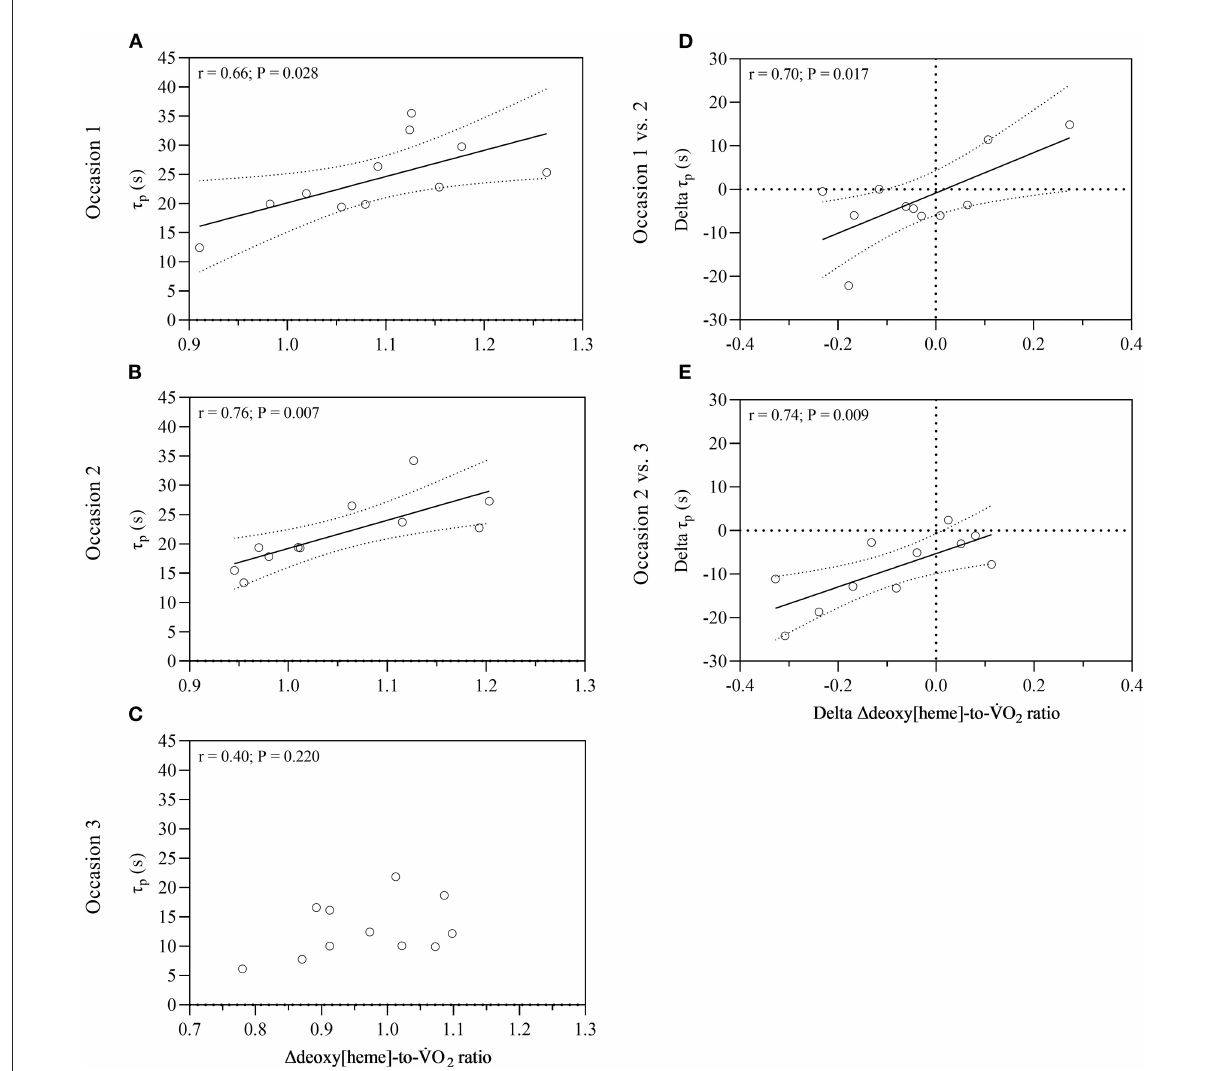
FIGURE2 Relationship between the normalized 1 deoxy[heme]-to-˙VO 2 ratio and fundamental phase τ p for all three occasions (A–C) , and between changes of the normalized 1 deoxy[heme]-to-˙VO 2 ratio and fundamental phase τ p over time (D,E) . Dotted lines represent 95% confidence bands. ˙VO 2 , pulmonary oxygen uptake; τ p , time constant of pulmonary oxygen uptake; r, coefficient of